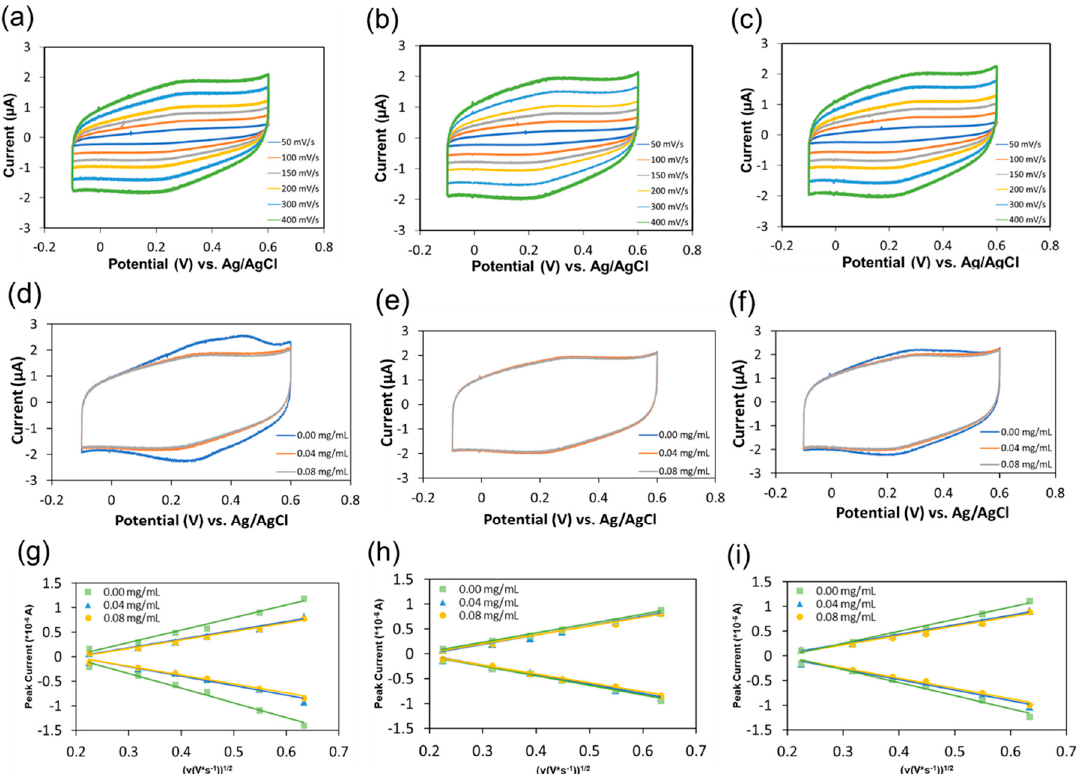
Figure 4. Representative cyclic voltammograms for the DPPH • -gold electrode system reacted with 0.04 mg/mL unmodified ( a ), –COOH-blocked ( b ), and –NH 2 -blocked CNDs ( c ) at scan rates of 50, 100, 150, 200, 300 and 400 mV/s, respectively; representative comparison of cyclic voltammograms for the